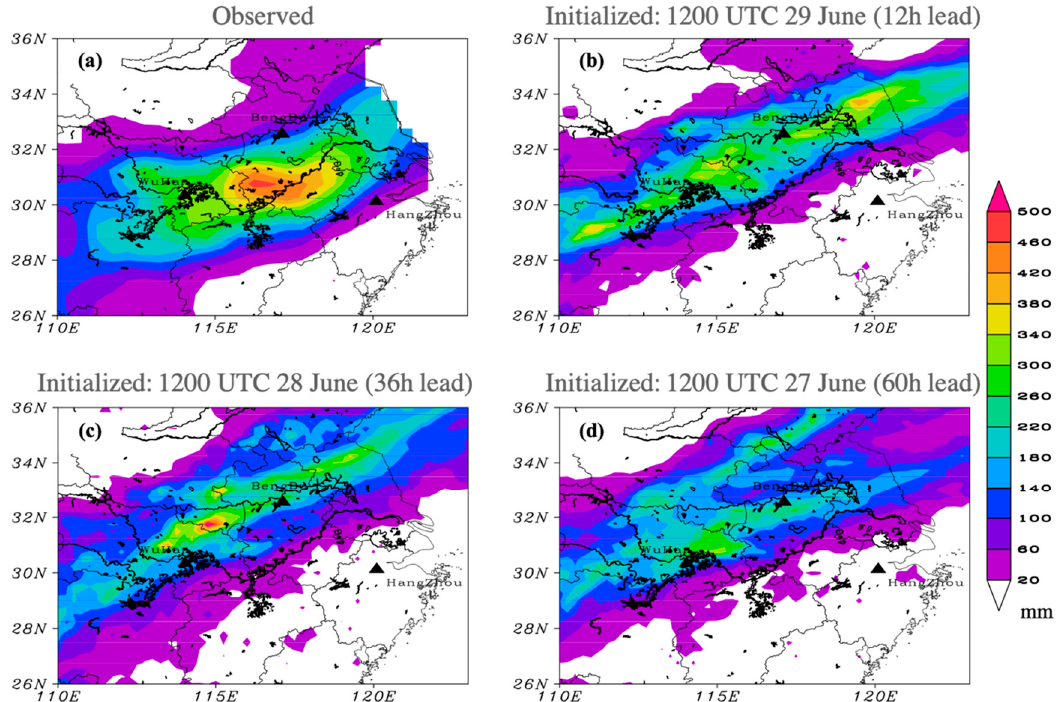
Figure 5. The event-total observed and the forecasted accumulated precipitation (mm) over the 5-day (120-h) period from 0000 UTC 30 June to 0000 UTC 5 July 2016. ( a ) Observed accumulated precipitation from daily rain gauge data in China which was interpolated to a 0.5° × 0.5° gridded domain. ( b – d ) ECMWF deterministic forecast 120-h forecasted accumulated precipitation initialized at 1200 UTC on 29, 28, and 27 June 2016, respectively. Thin black lines denote political boundaries and thick black lines denote the Huanghe and Yangtze Rivers to the north and south, respectively.